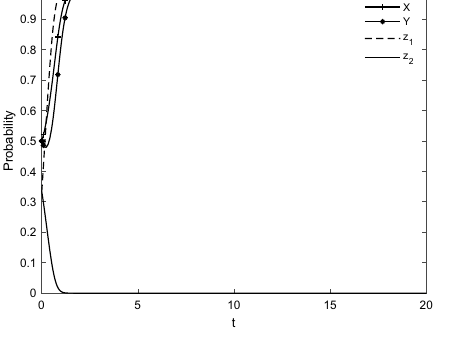
(a) The impact on the choice of strategy of each game player. Figure 3. Initial